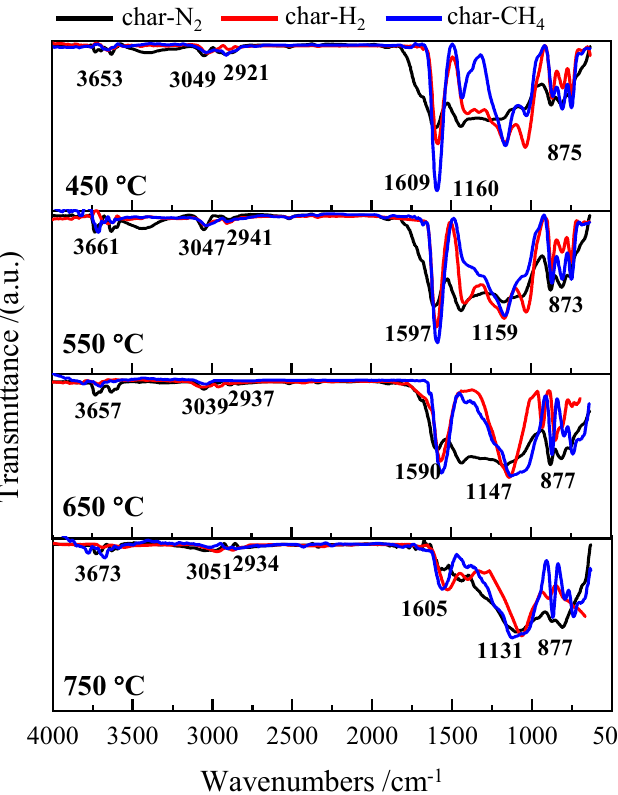
Figure 4. Infrared spectra of semi − coke (N 2 , H 2 , and CH 4 ) at different pyrolysis temperatures. Figure 3c is the release curve of H 2 O during coal pyrolysis. It can be seen that the